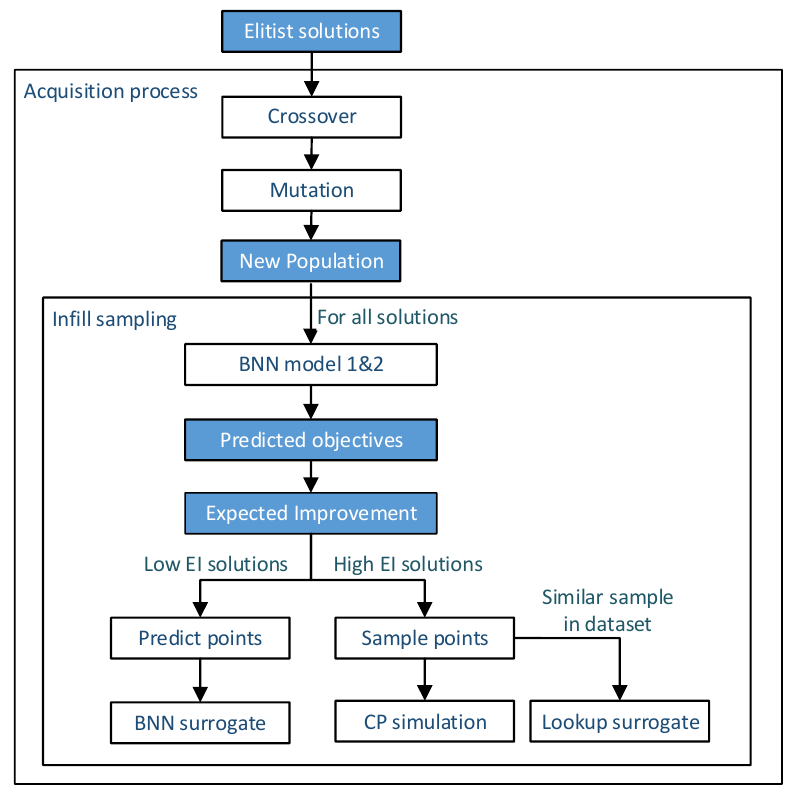
Figure 5. Workflow of acquisition process and infill sampling.